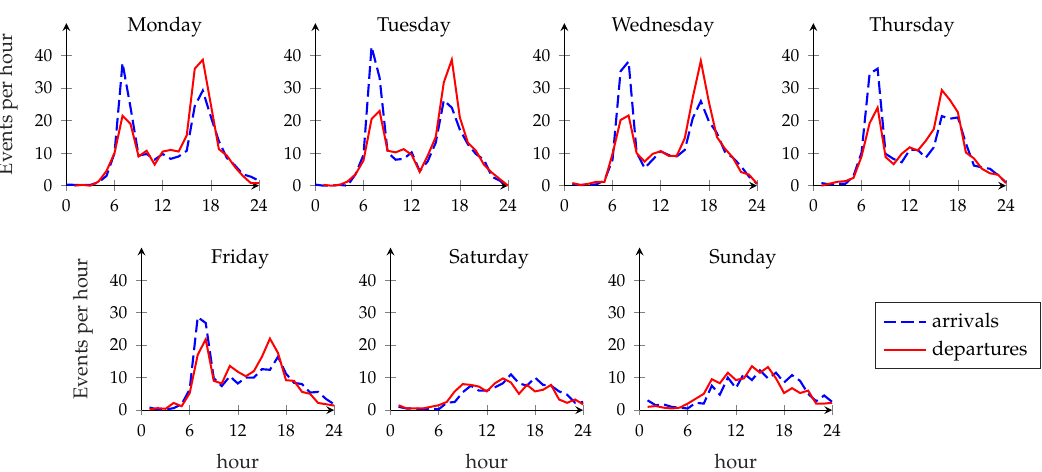
Figure 2. Traffic patterns for the month of July 2015 at station 537 (Lexington Ave. and East 24th